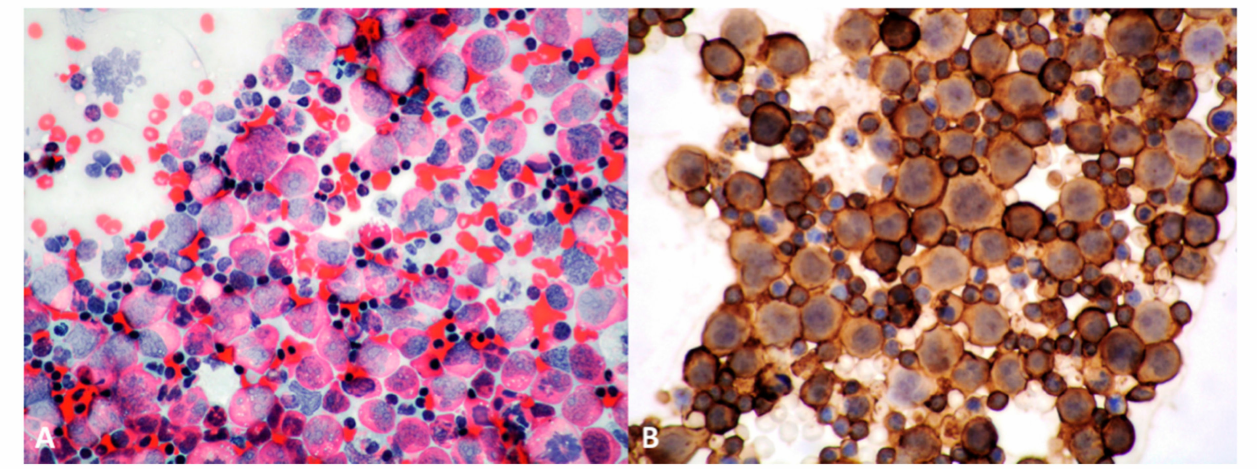
Figure 5. Primary effusion lymphoma. ( A ). Large tumor cells are abundant in this pleural fluid sample (Papanicolau stain, 400 × ). ( B ). There is diffuse and intensemembranous and cytoplasmic staining for CD45 (Leukocyte Common Antigen) (CD45 immunostain, 400 ×